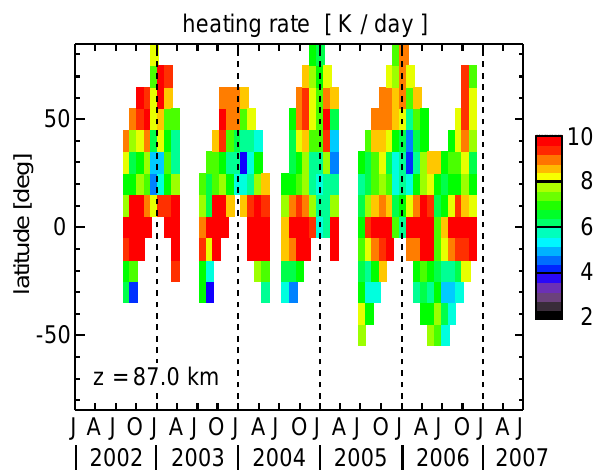
Fig. 1. Latitudinal distribution of chemical heating rates derived from SCIAMACHY hydroxyl nightglow emissions at 87km alti- tude for the period